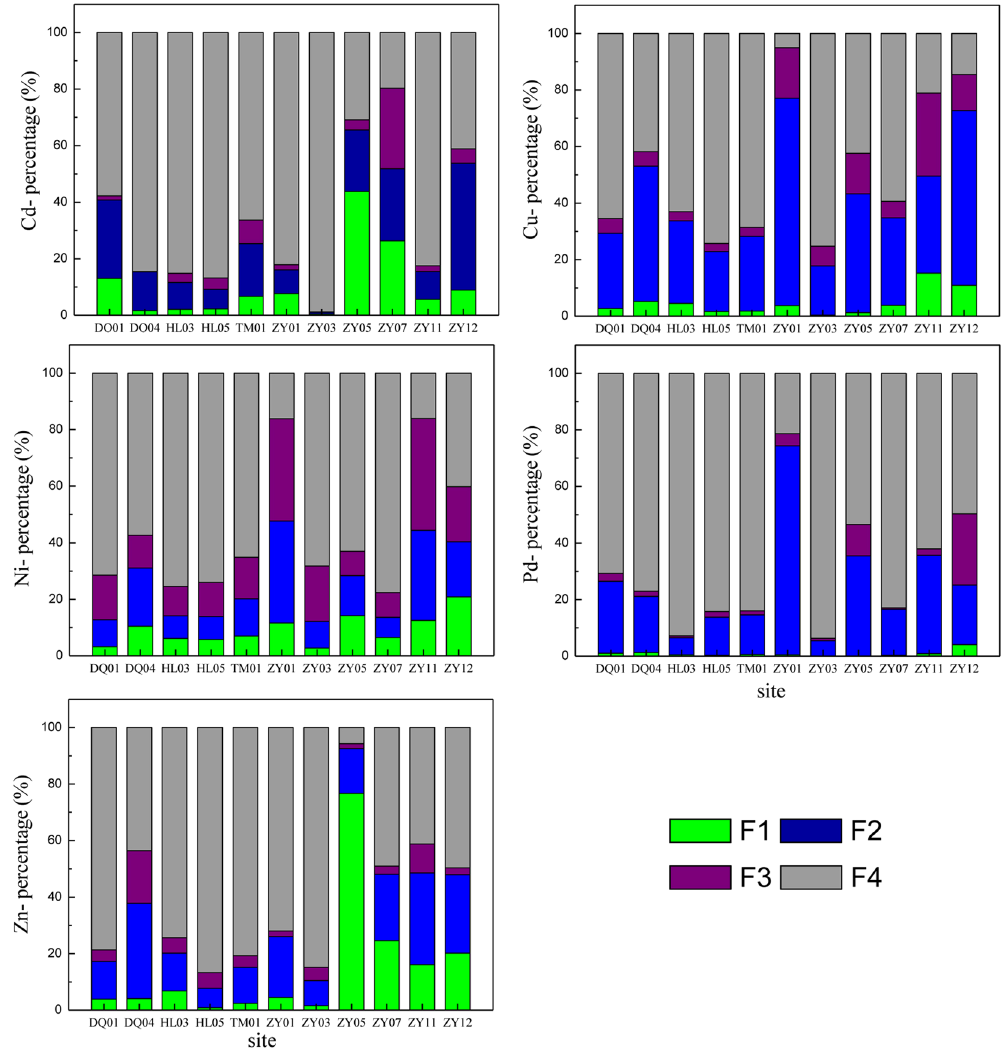
Figure 4. Percentages of the total Cd, Cu, Ni, Pb, and Zn concentrations found in the four chemical fractions F1–F4 in the sediment samples in the Haihe River. (F1 is the water- and acid-soluble fraction, F2 is the reducible fraction, F3 is the oxidizable fraction, and F4 is the residual